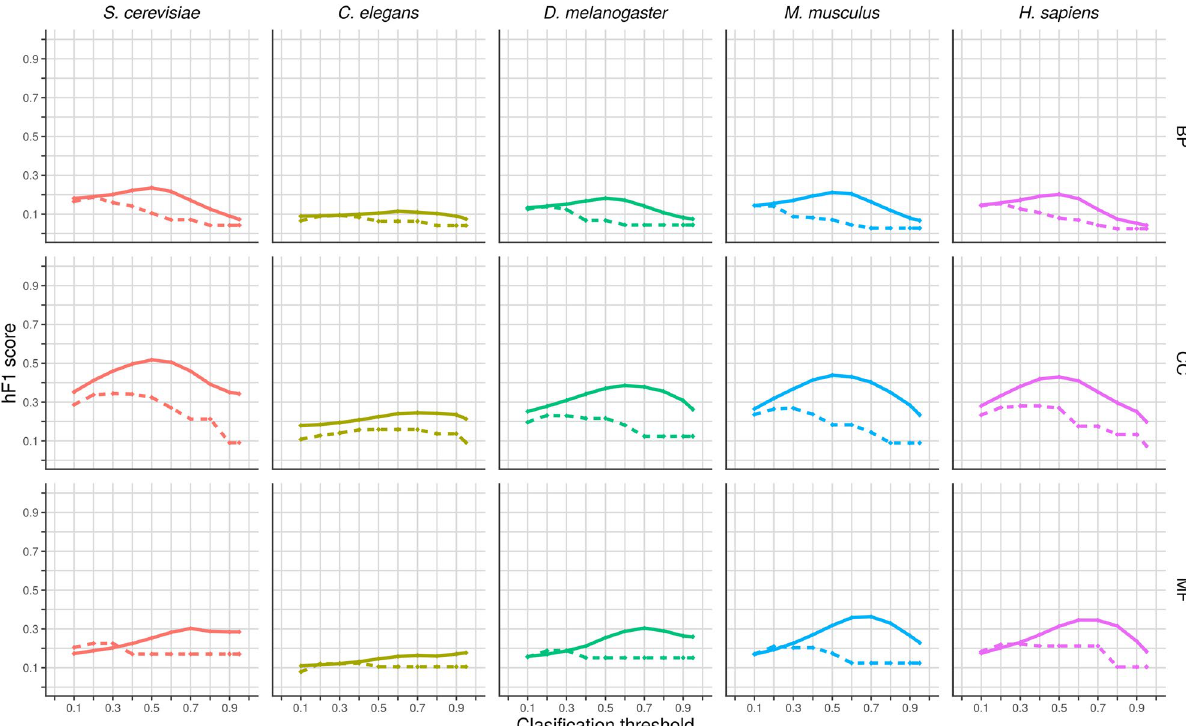
Figure 3. Hierarchical F1 over the test set for each trained and random model as a function of the classification threshold. In each plot the classification threshold, ranging from 0 to 1, is depicted in the x axis and the hF1, also ranging from 0 to 1, is depicted in the y axis. Trained models are represented by solid lines and random models by dotted lines. Each column of the panel corresponds to an organism and each row to an ontology (BP: Biological Process, CC: Cellular Component, MF: Molecular